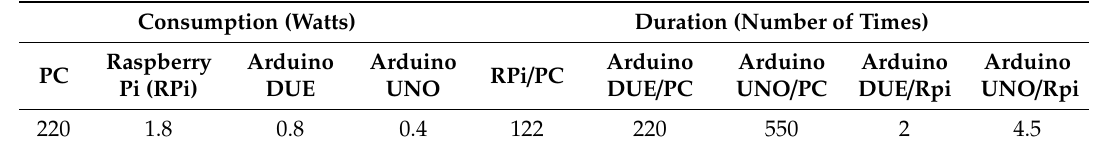
Table 1. Consumption and time-comparison of di ff erent low capacity processors